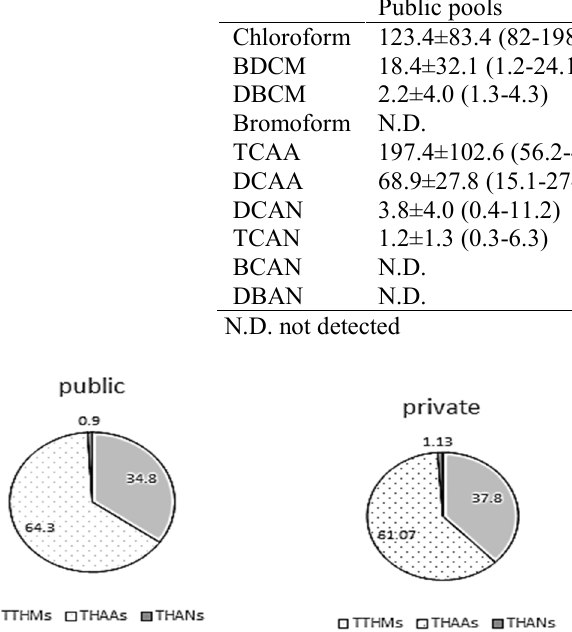
Table 2. DBP concentrations (µg/L) in samples from public and private swimming pools Public pools Private pools